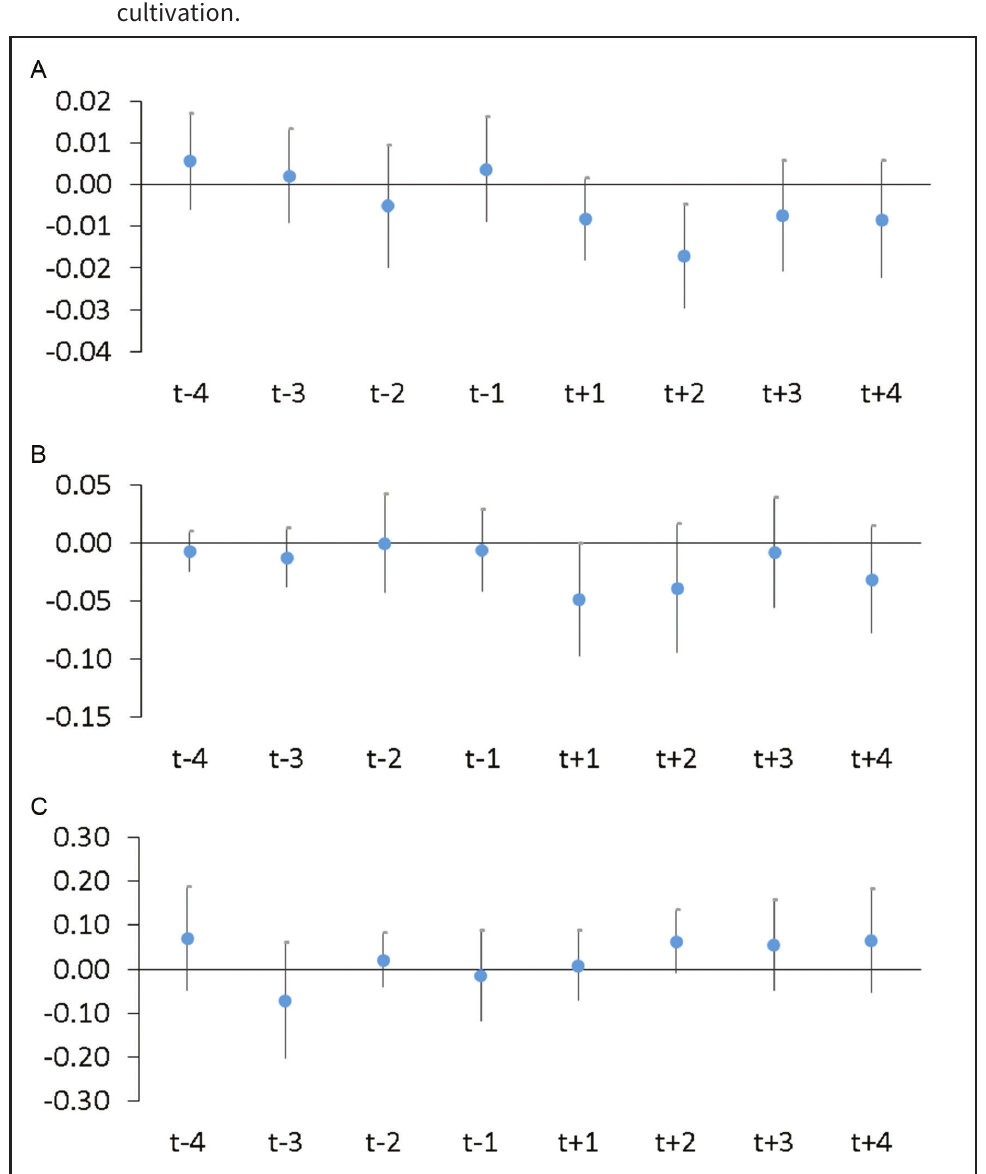
Figure 3 Response estimates of conflict on Economic Activity. (A) Conflict and nighttime light. (B) Conflict and active formal firms. (C) Conflict and land devoted to poppy